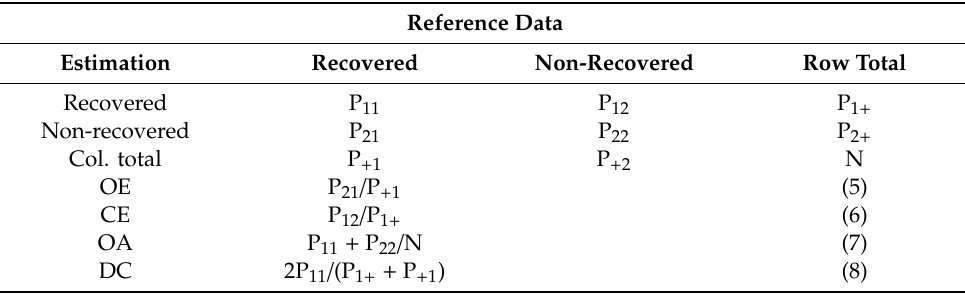
Table 2. Confusion matrix example.